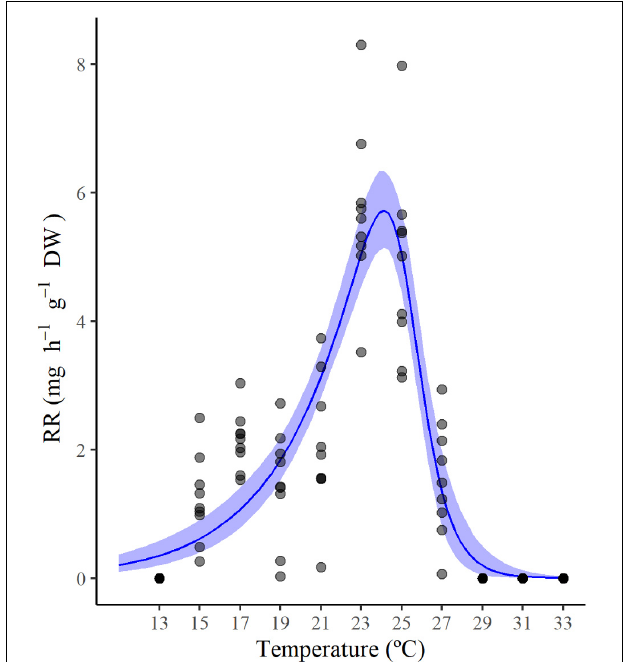
FIGURE 1 | Thermal performance curve of Pennaria disticha according to the selected model (Sharpe-Schoolfield). Shaded area corresponds to the confidence intervals. Darker dots represent overlapped individual respiration rate